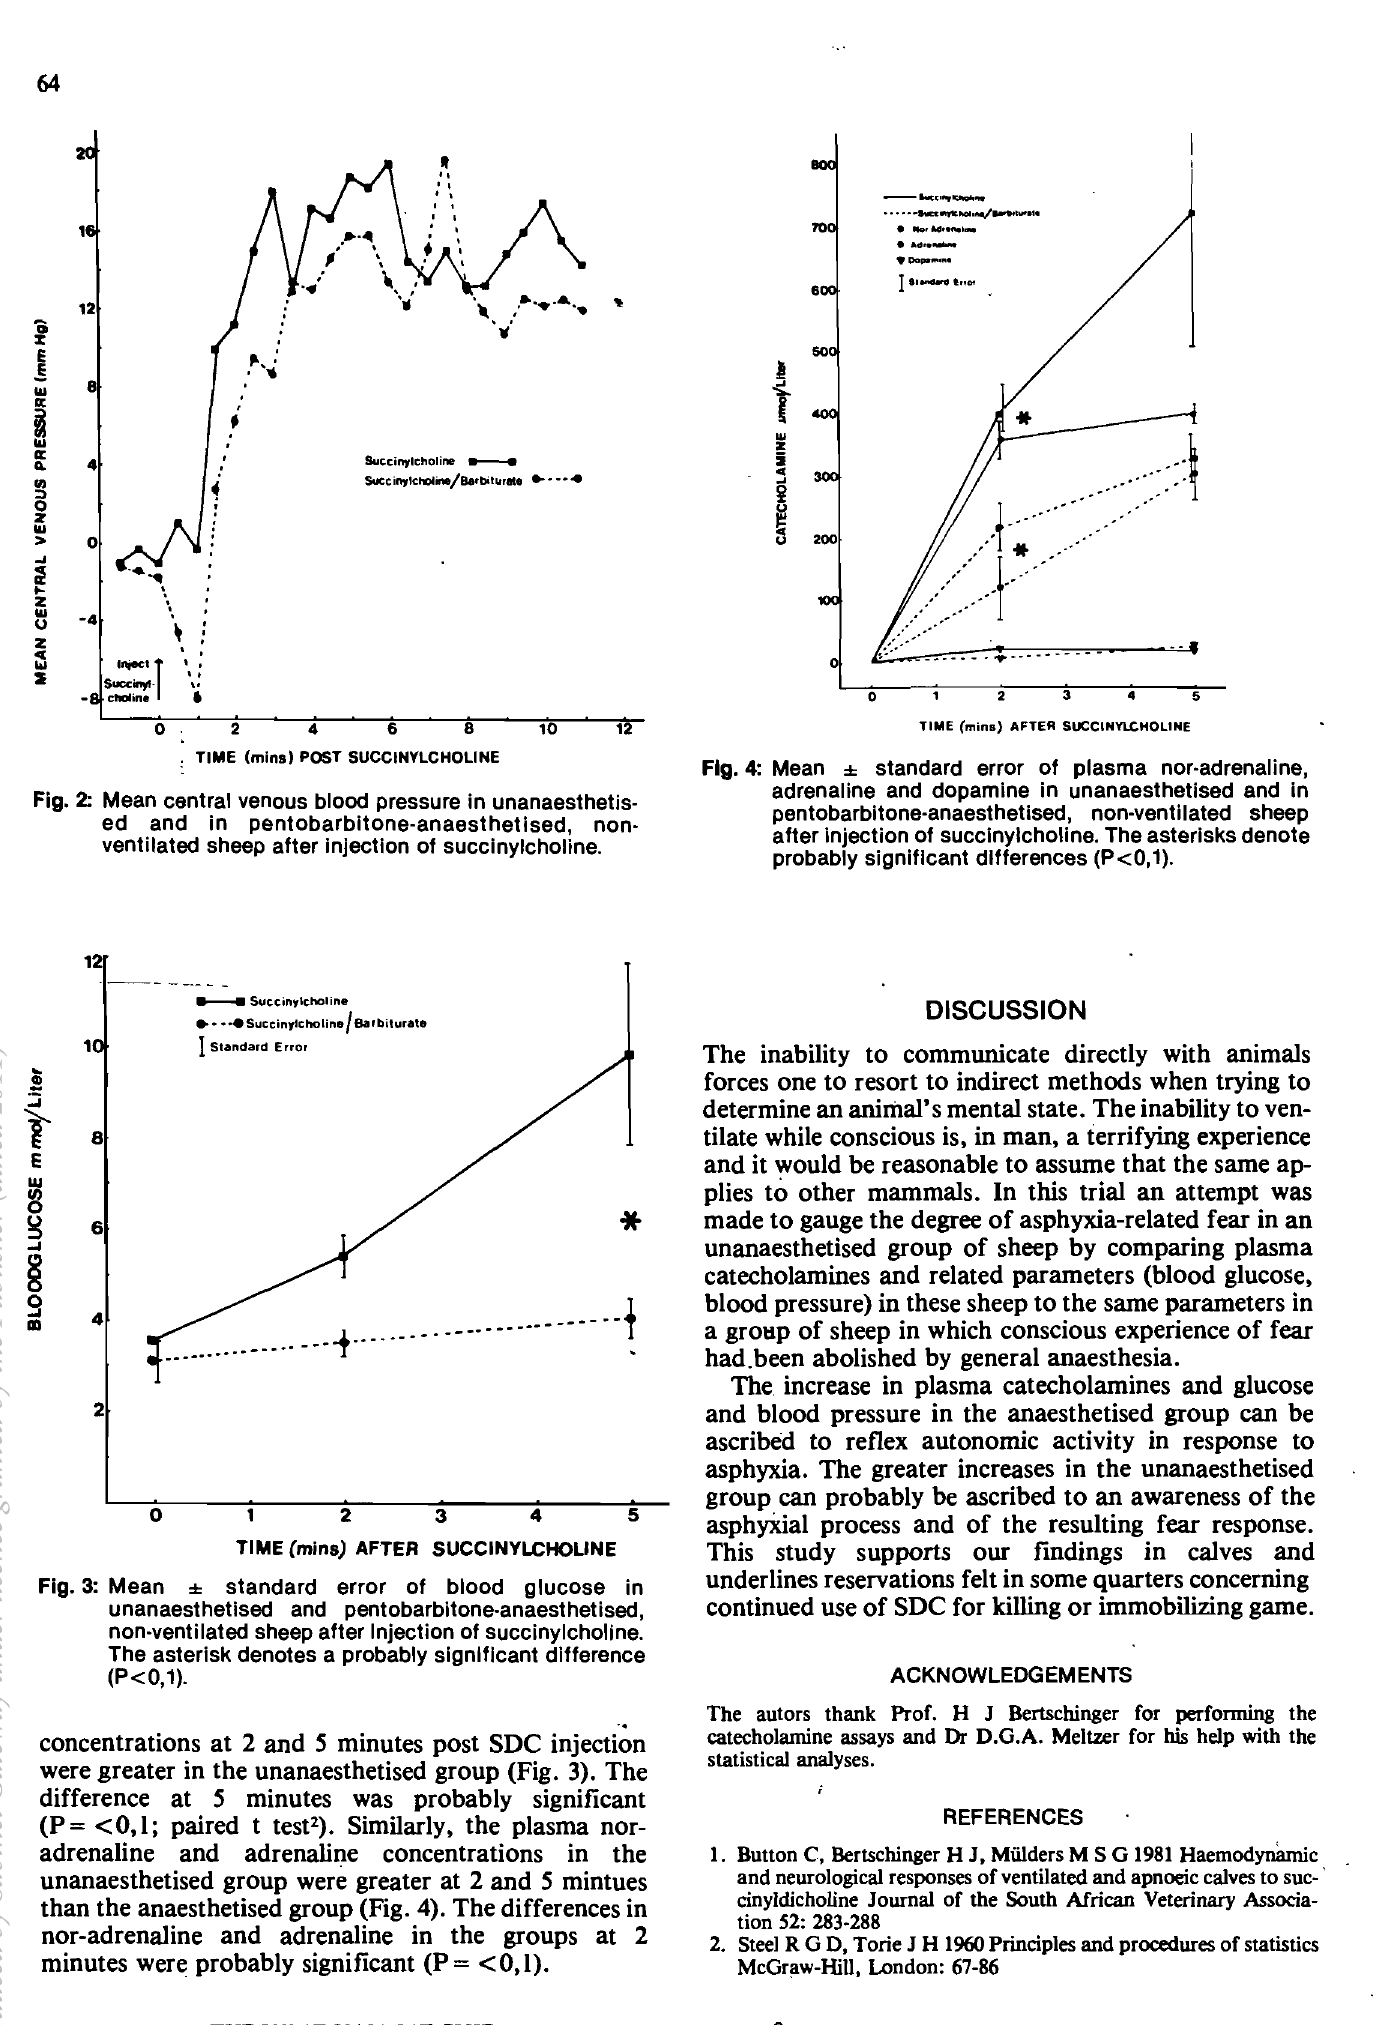
Fig. 3: Mean ± standard error of blood glucose in unanaesthetised and pentobarbitone-anaesthetised, non·ventilated sheep after Injection of succinylcholine. The asterisk denotes a probably significant difference (P<0,1).